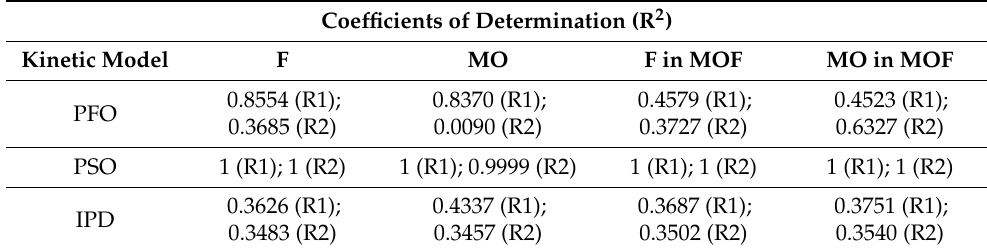
Table 5. Values of coefficients of determinations (R 2 ) obtained for all kinetic models considered.